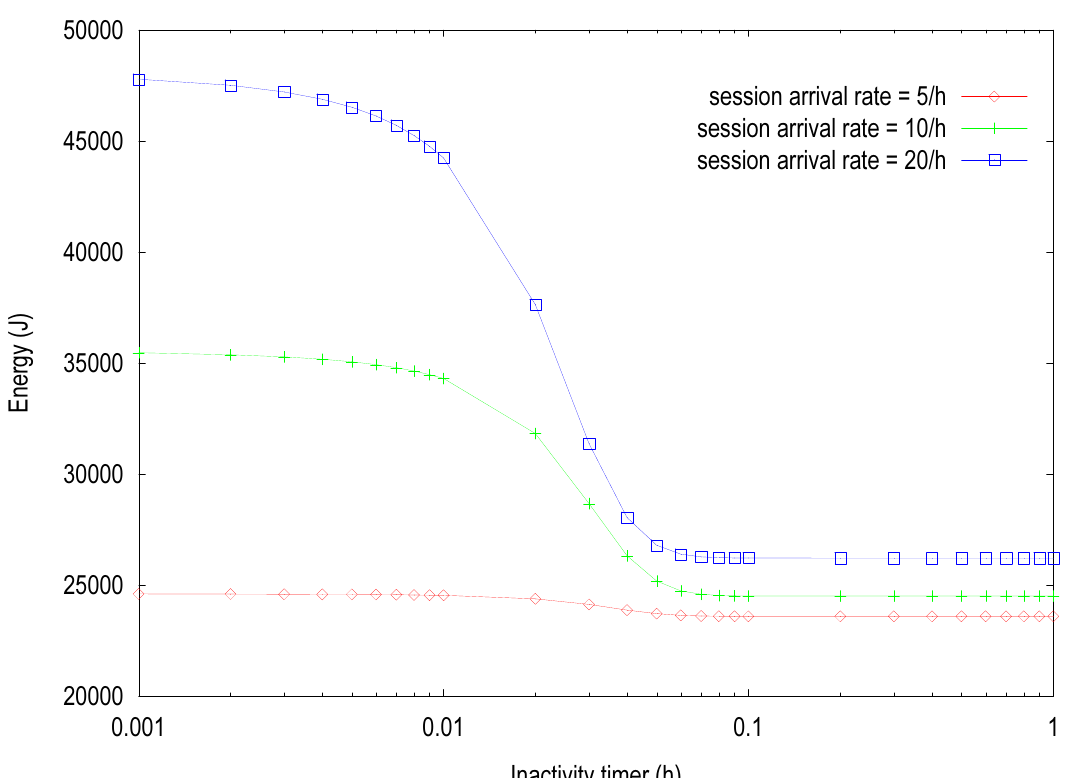
Figure 5. Energy consumption by varying the session arrival rate (large values of T and T E W